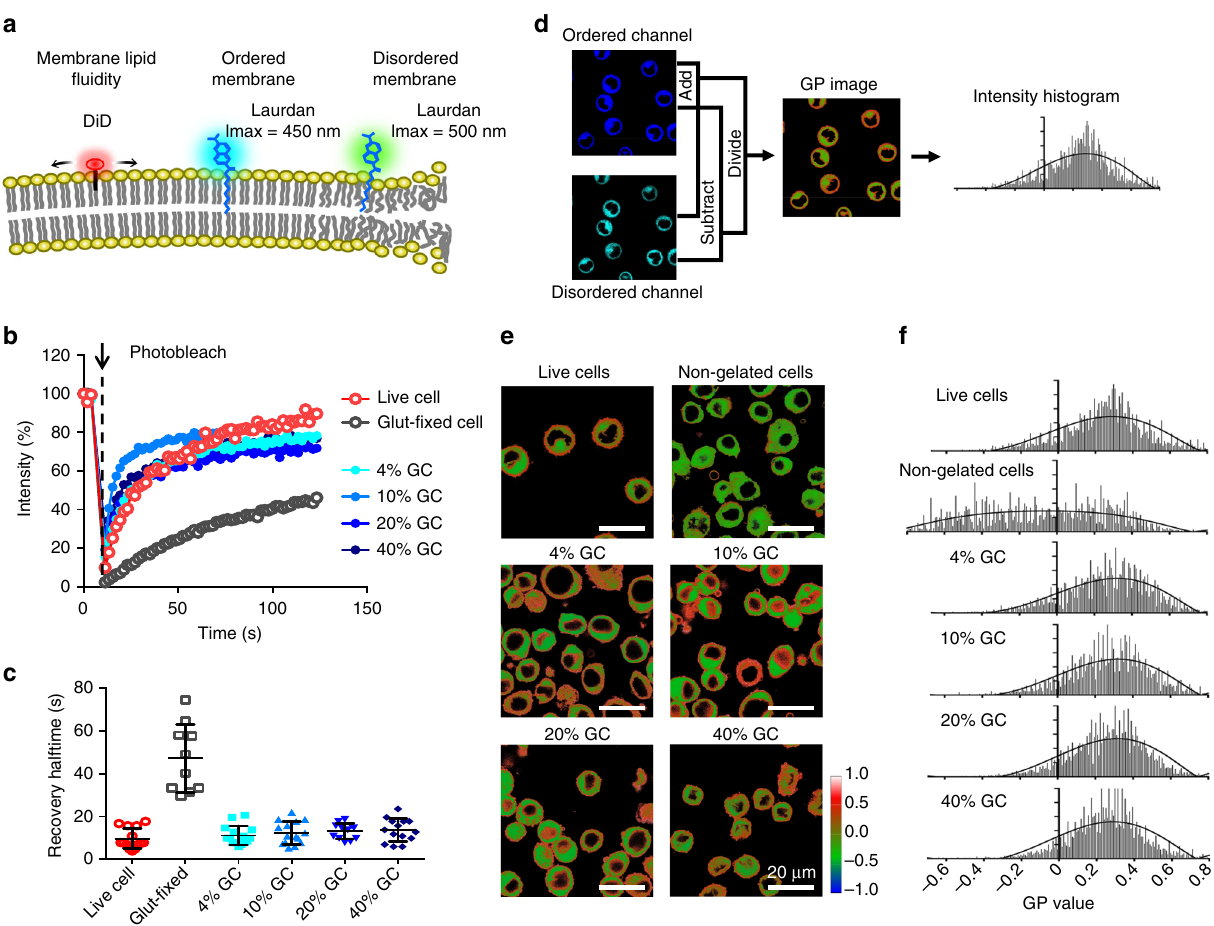
Fig. 3 Examination of lipid fl uidity and membrane order on the plasma membrane of GCs. a A schematic illustration of the fl uorescent probes used for assessing lipid fl uidity (DiD) and membrane order (Laurdan). b Representative fl uorescence recovery curves after photobleaching of DiD dye on HeLa cells, glutaraldehyde- fi xed cells, and GCs of different hydrogel densities. c Halftimes of DiD dye fl uorescence recovery following photobleaching for live HeLa cells, glutaraldehyde- fi xed HeLa cells, and gelated HeLa cells with different hydrogel densities. No signi fi cant difference was observed between each of the GCs and live cells. Error bars represent mean ± standard deviation, ( n = 10 – 15). d A fl owchart illustrating the derivation of generalized polarization (GP) values from confocal images in the ordered and disordered channels. e Representative pseudo-colored GP-intensity-merged images of live HeLa cells, nongelated control cells, and GCs of different hydrogel densities. Ordered membrane domains are shown in orange. Scale bars = 20 μ m. Color scale corresponds to GP value. f Histograms of GP values comparing the membrane order of the plasma membrane on live cells, nongelated control cells and